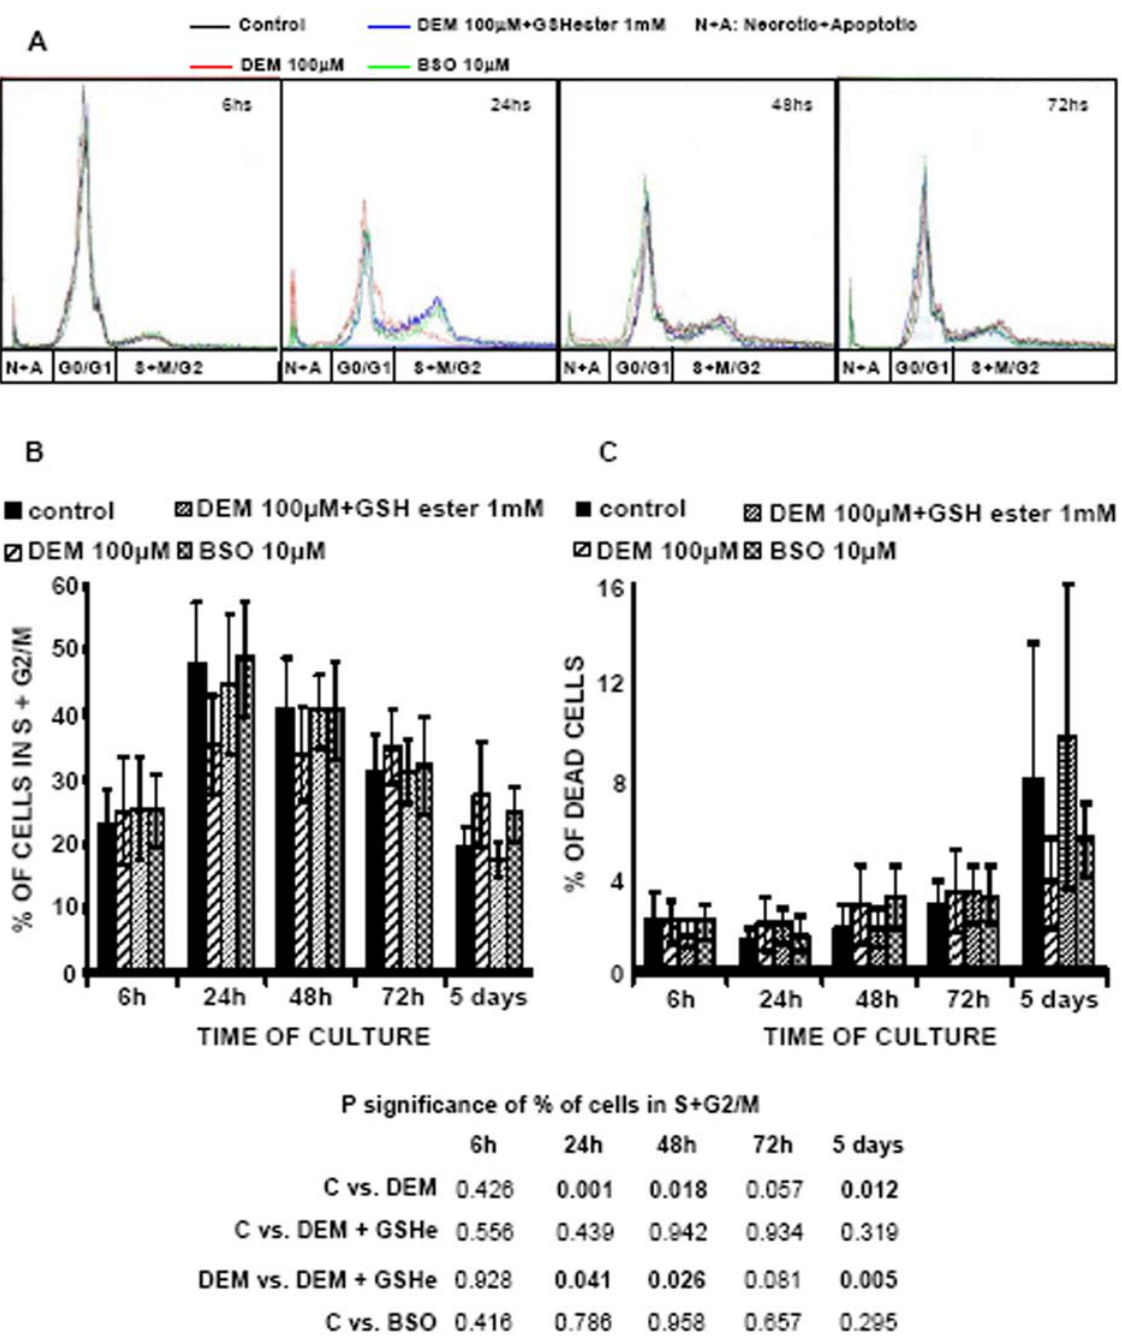
Figure 6. Effect of nuclear GSH depletion by DEM and BSO on cell cycle. Cells were plated and treated as described previously. The cell cycle was studied by flow cytometry, using the level of the fluorescence of the DNA dye propidium iodide (final concentration, 5 m g/mL) at 630 nm fluorescence emission as a measure of the DNA content per cell, as described in materials and methods. The cells were detached, fixed in ethanol and stained along the proliferation curve of the 3T3 fibroblasts. The histograms corresponding to each experimental group at 6 h, 24 h, 48 h, and 5 days of culture (of the same representative experiment) were overlaid and presented at the panel A. The effect of the GSH depletion on the cell proliferation, defined by mean percentages of cells in phases S + M/G2 6 SD, is presented at the panel B, and the effect of the depletion on the cell death, i.e. the percentage of apoptotic and necrotic cells is shown on the panel C. The results presented are mean 6 SD of 5–17 different experiments. doi:10.1371/journal.pone.0006413.g006 Clearly, many of the reported effects of DEM on 3T3 fibroblasts last for no more than 3 days and at day 6 DEM treated cells show a profile of glutathionylated proteins similar to controls, although nuclear carbonyls remain higher in cells incubated with DEM.